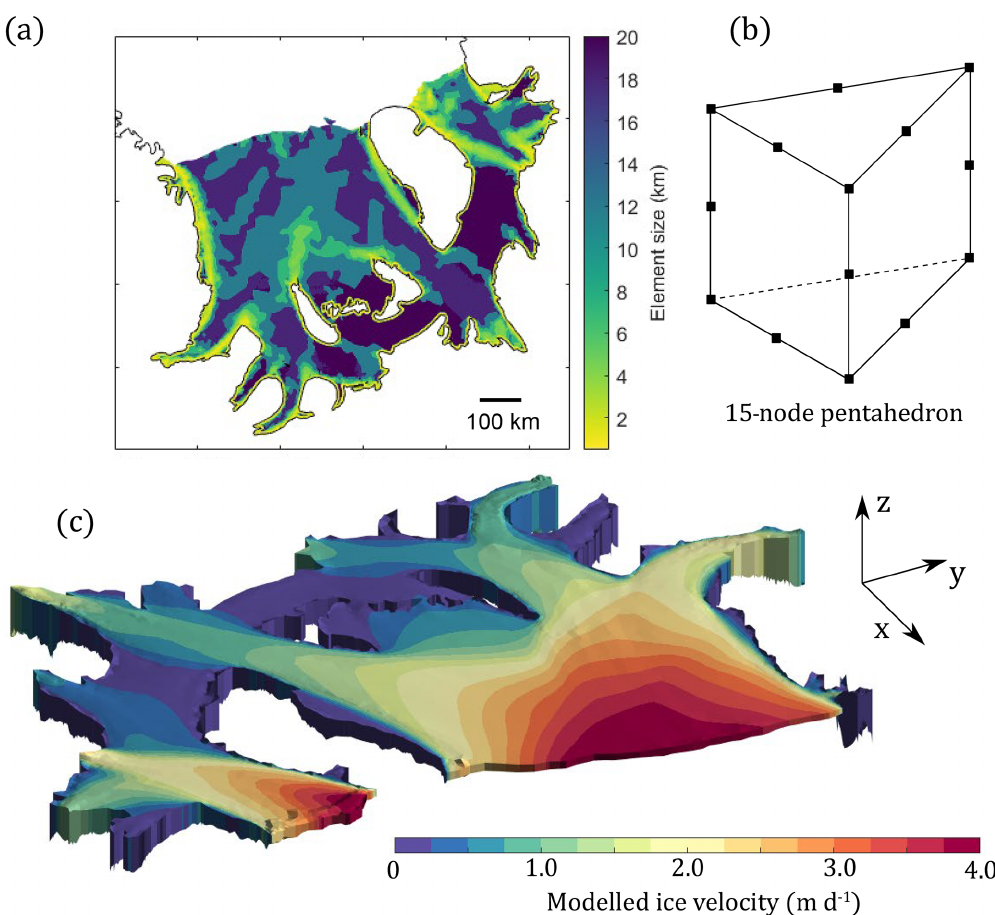
Figure 2. Overview of the finite-element model, showing model resolution (a) , the quadratic pentahedral elements used (b) and a vertically exaggerated oblique view of the model showing modelled mean ice velocity for the default setup experiment (c)